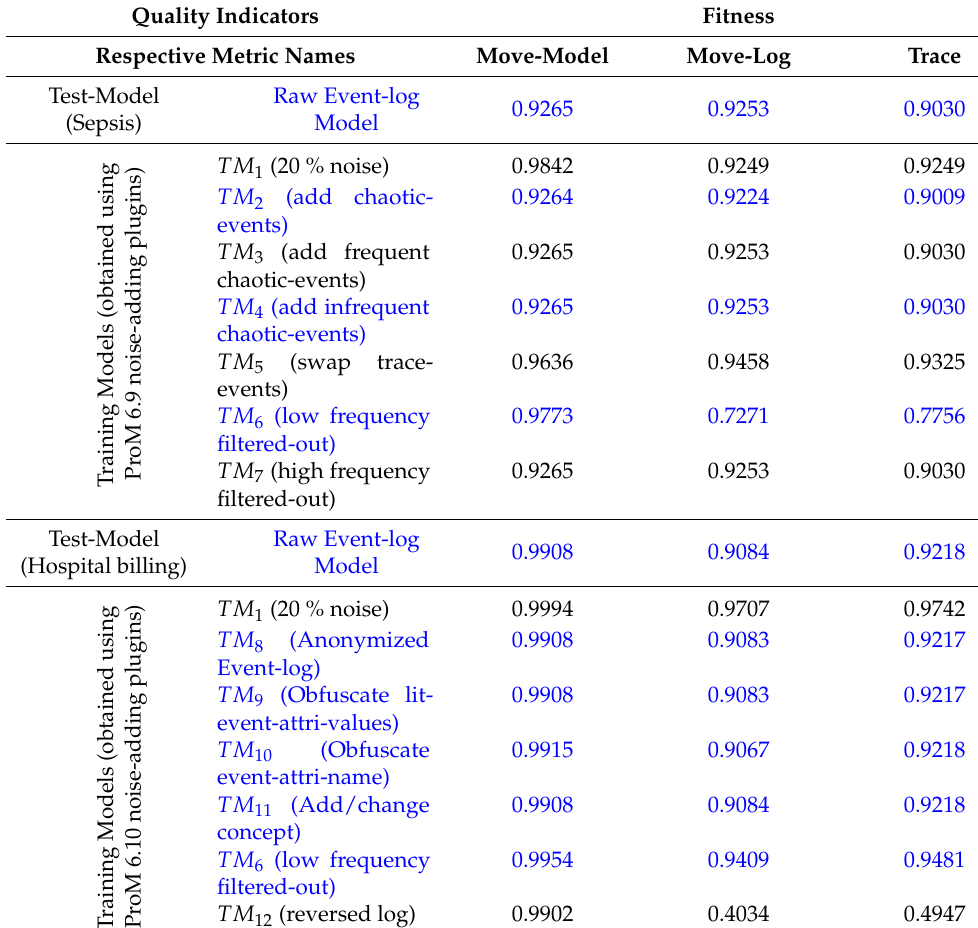
Table 1. ProM experiments results for the 2 test models and 12 training models using noise-adding plugins